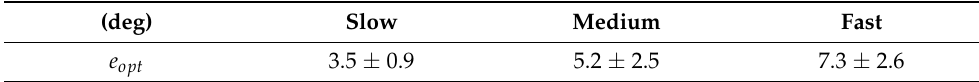
Table 5. Mean ± STD Errors for Each Rotation Rate